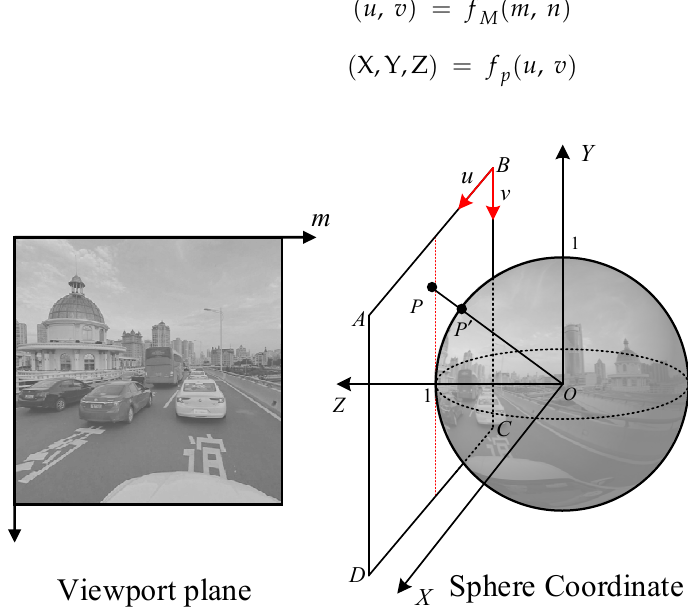
Figure 2. Procedure to render the viewport from the 360 ◦ image. The detailed processes of f M ( m , n ) and f p ( u , v ) vary according to the projection method, which could be the perspective projection [33], stereographic projection [33], and so on. Note that the UV plane is an intermediate surface on which the sample data is projected. The viewers can watch the screen of the viewport plane, not the UV plane.